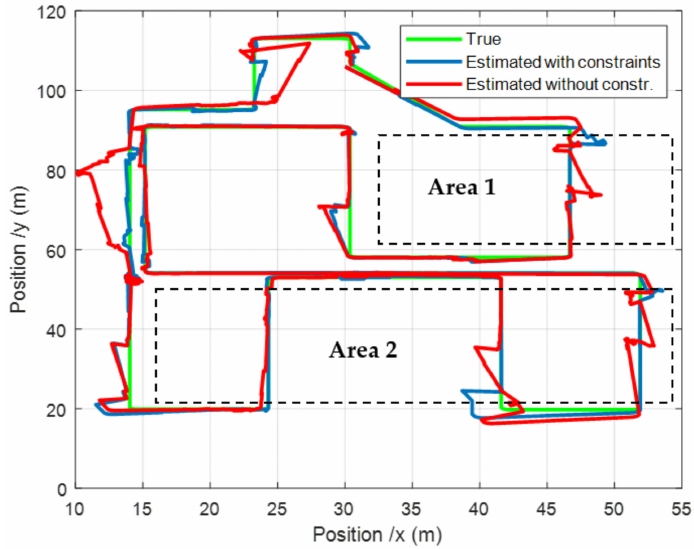
Figure 7. Comparison of the 2D positions with and without constraint applications.